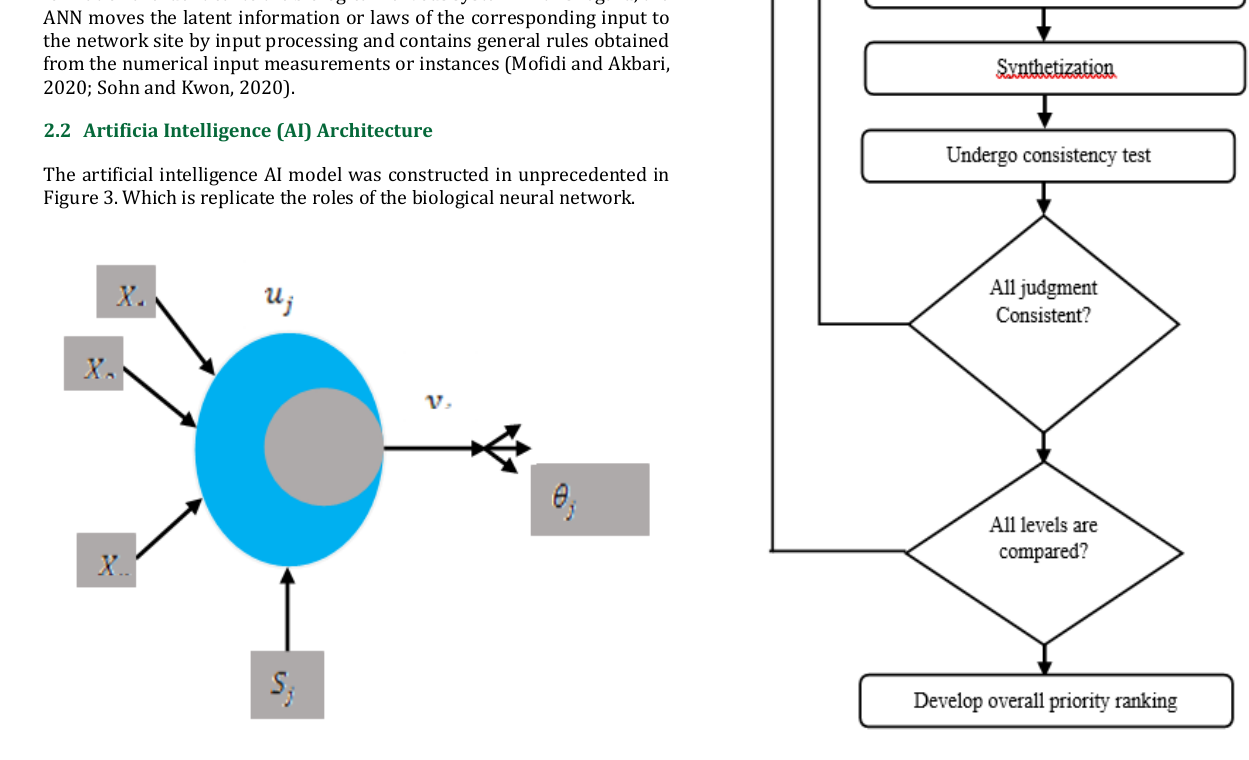
Figure 4: The design of a concept analytic hierarchy process (Olabanji and Mpofu,